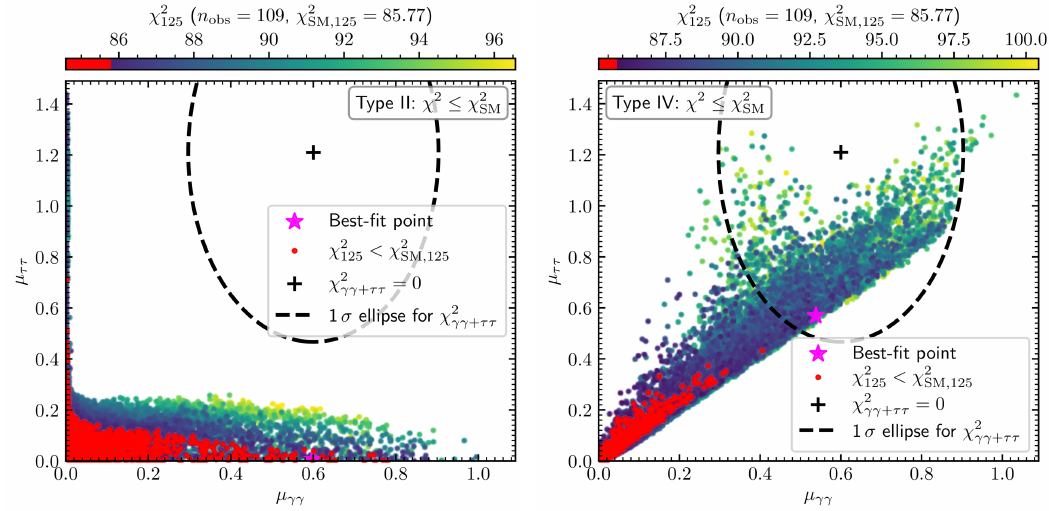
Figure 1 . µ ττ in dependence of µ γγ in the N2HDM type II (left) and type IV (right). The color coding indicates the value of χ 2 . Red points predict χ 2 < χ 2 . The 1 σ confidence-level 125 125 SM , 125 region with regards to χ 2 is indicated by the dashed black line. The best-fit point is indicated γγ + ττ with a magenta